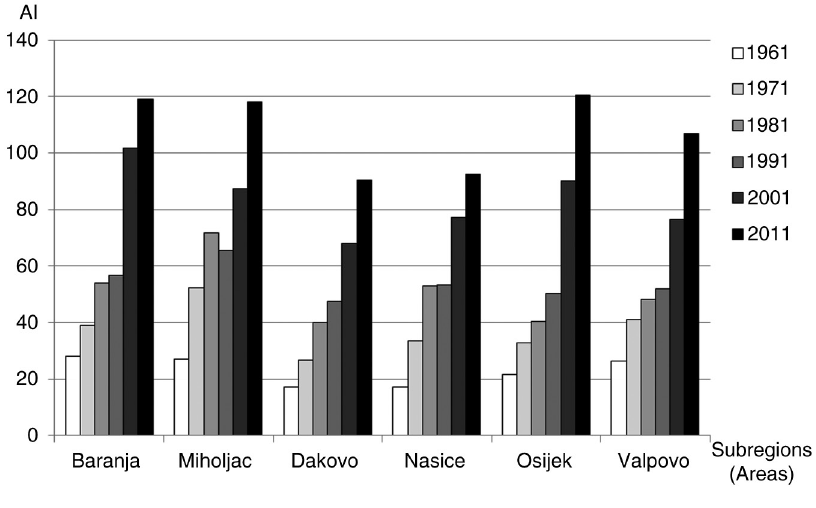
Figure 2. Ageing index in the rural settlements of the six sub-regions of Osijek-Baranja County in the period 1961 (cid:2) 2001. Source : CBS